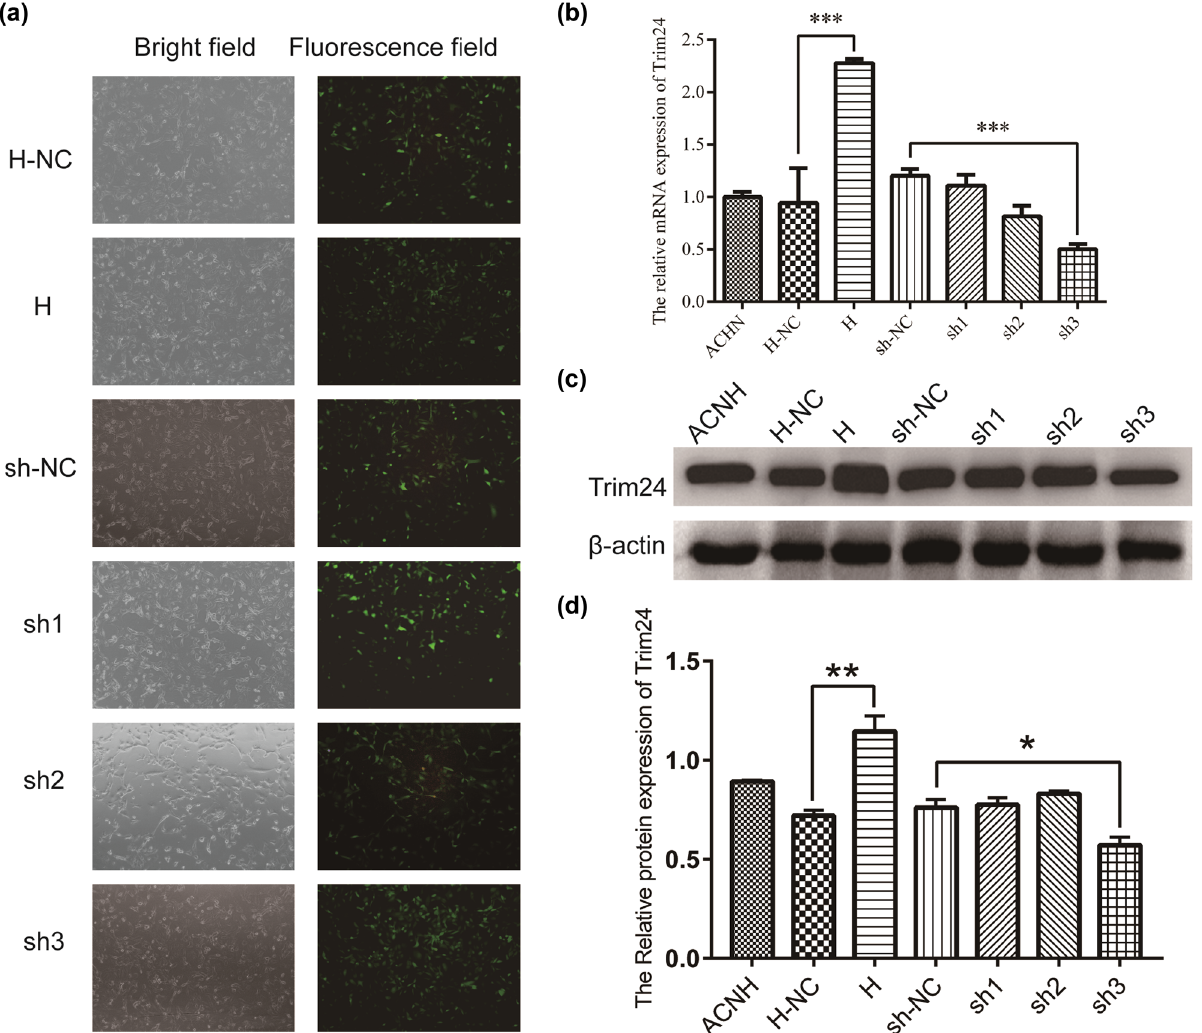
Figure 1: The construction of Trim24 overexpression and knockdown cell lines using lentivirus infection. ACHN cells were infected with pLenR - GTP, pLenR - GTP - Trim24, pLenR - GTP - sh - NC, pLenR - GTP - Trim24 - SH1, pLenR - GTP - Trim24 - SH2, and pLenR - GTP - Trim24 - SH3 to generate the H - NC, H, sh - NC, sh1, sh2, and sh3 cells, respectively. ( a ) Bright and fl uorescence intensity fi eld at the same area were photo - graphed using a fl uorescence microscope. ( b ) The relative mRNA levels were detected by qPCR. ( c ) Western blot was performed to con fi rm the protein levels of these fi ve group cells. ( d ) Analysis of the relative protein expression of Trim24. * P < 0.05, ** P < 0.01, and *** p <